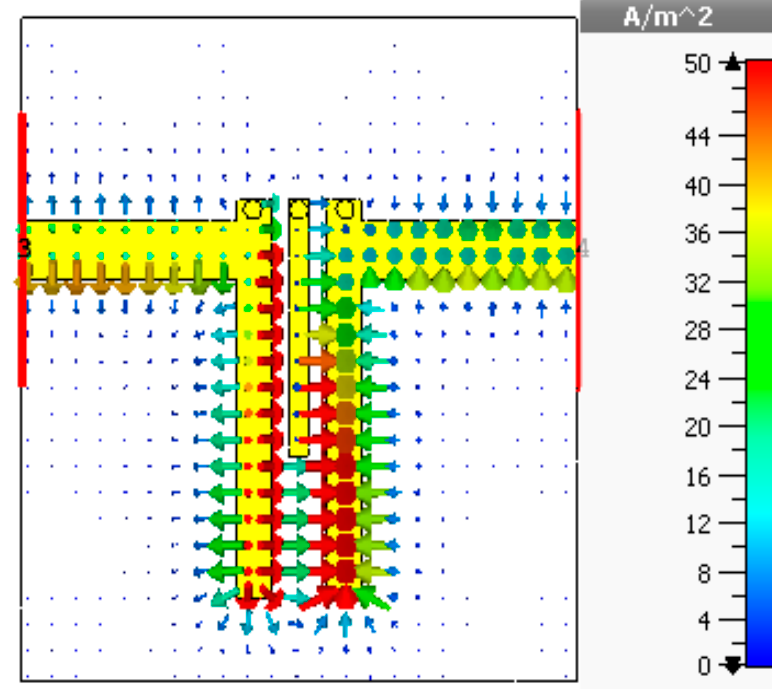
Figure 6. Simulated surface field analysis for the basic three-pole planar BPF design.